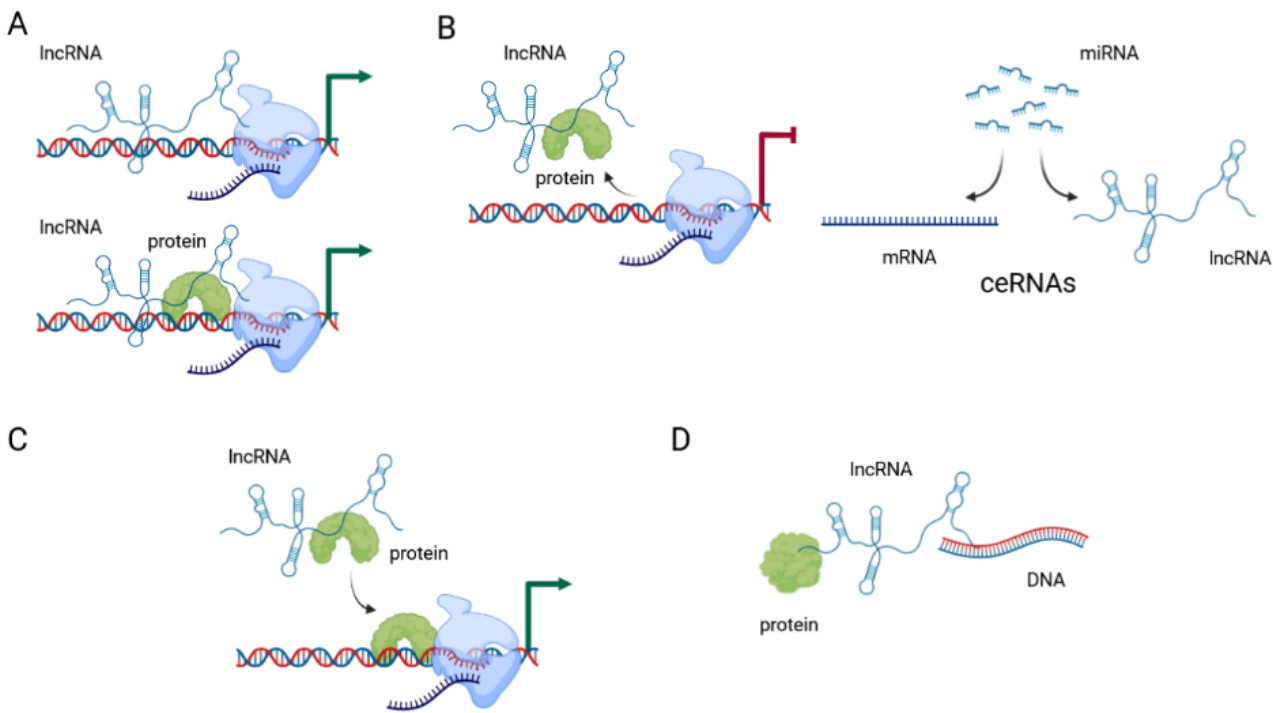
Figure 2. Functional roles of lncRNAs. ( A ) As signal molecules, lncRNAs act either alone or in combination with proteins like transcription factors to mediate the transcription of downstream genes; ( B ) As decoys, lncRNAs either bind to functional proteins to block their activity or compete with mRNAs for binding to miRNAs to block their inhibitory effects on mRNAs; ( C ) As guides, lncRNAs carry and locate functional proteins in the target area to perform their functions; ( D ) As scaffolds, lncRNAs guide different types of macromolecules to assemble complexes and facilitate their interactions. Created with BioRender.com .